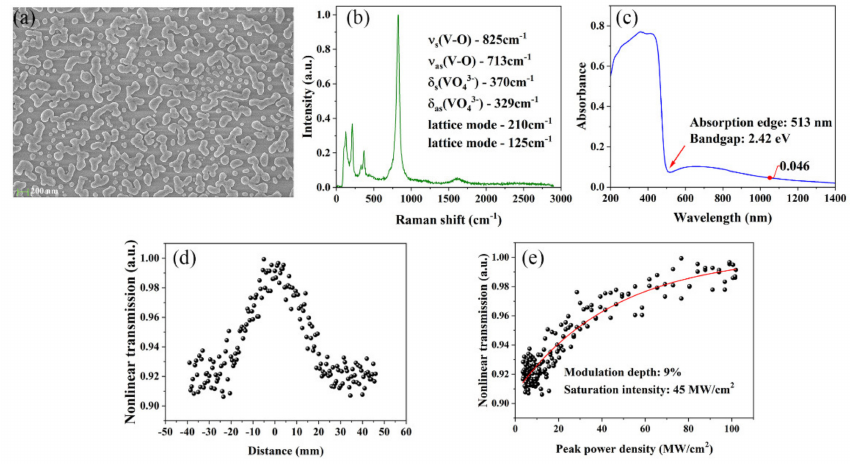
Figure 1. ( a ) The TEM image. ( b ) The Raman spectrum. ( c ) Absorptance of the Mo:BiVO 4 film. ( d ) Z- scan curve of Mo:BiVO 4 -SA. ( e ) The dependence of nonlinear transmission on peak power